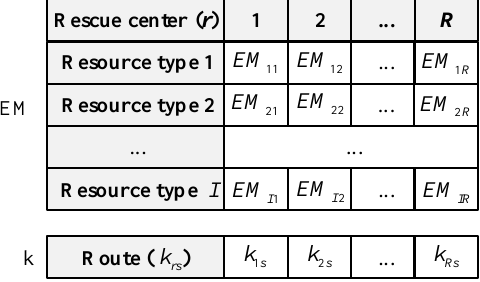
Figure 2. A simple example of a chromosome .